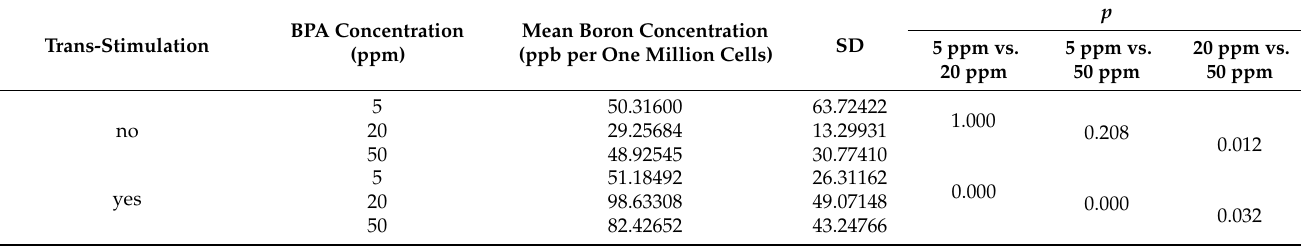
Table 2. Results of the Games–Howell post hoc test—significant differences were detected within the trans-stimulated groups. Trans-Stimulation